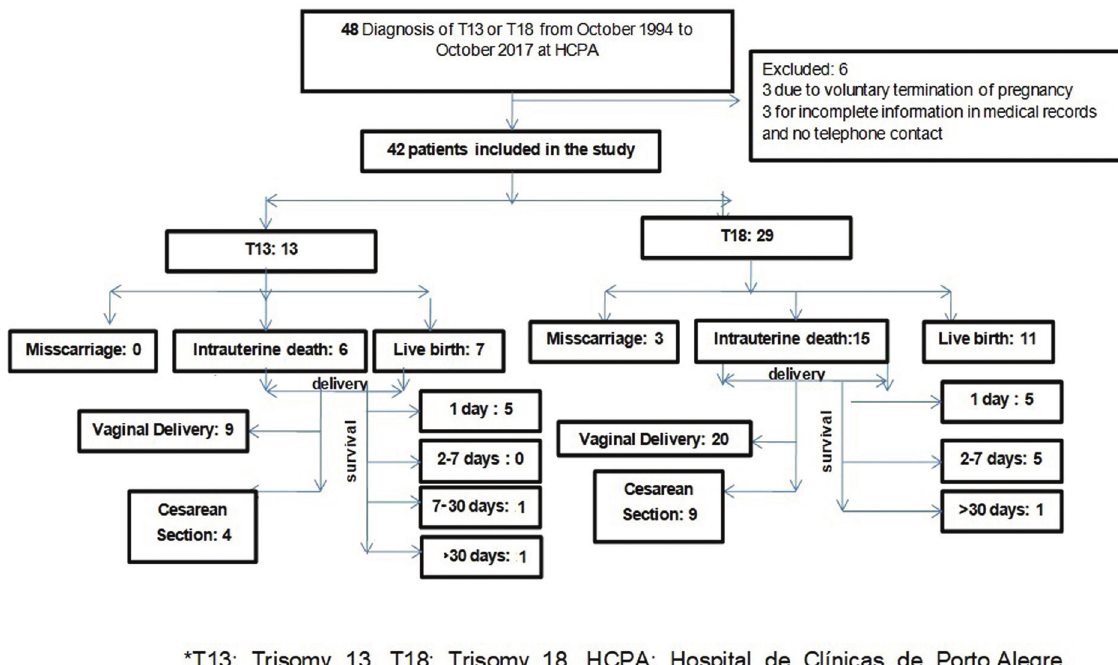
Figure 1 - Flowchart of patients diagnosed with trisomy 13 or trisomy 18.